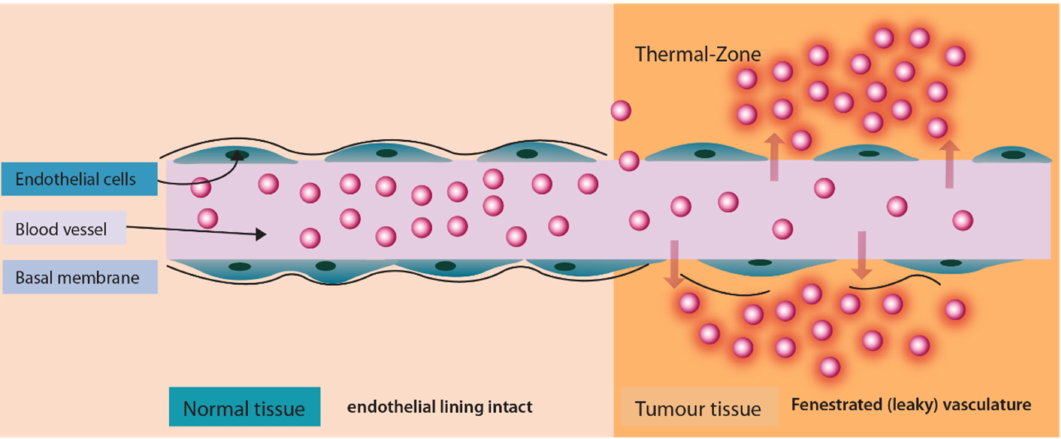
Figure 8. Enhanced liposomal extravasation and drug release at tumor site upon application of